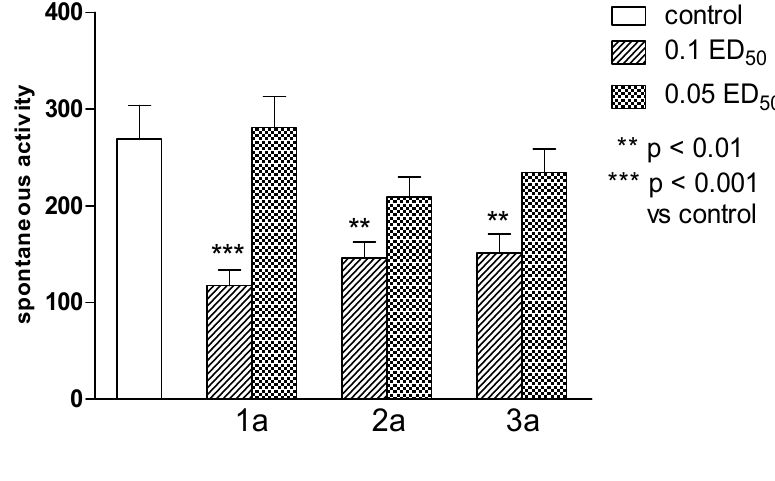
= 6.857; (6.49) ( p < 0.001) and 50 ( p < 50